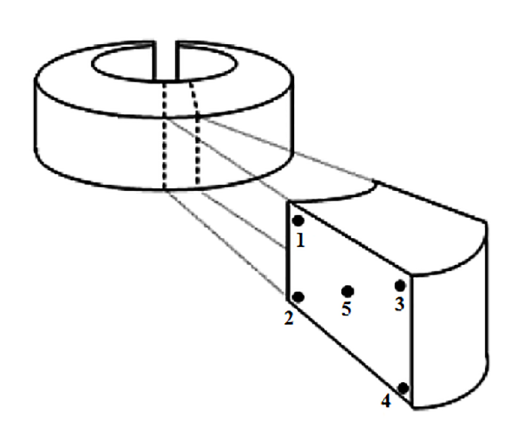
Figure 3. Location of the hardness measurements in the transversal cross-section of the quenched